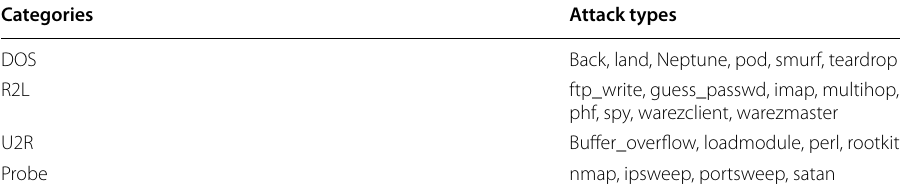
Table 1 Attacks in the NSL-KDD database